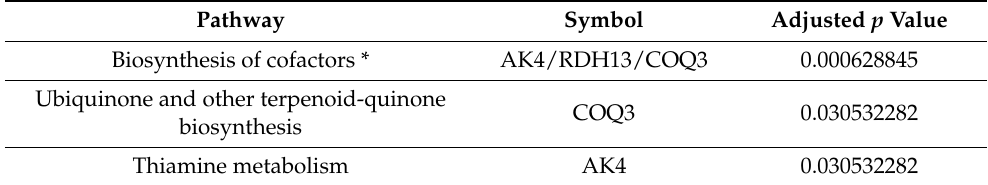
Table 3. Pathway analysis of the mitochondria-related nuclear genes with a difference over 0.3 of variant percentage between the proband and control groups.